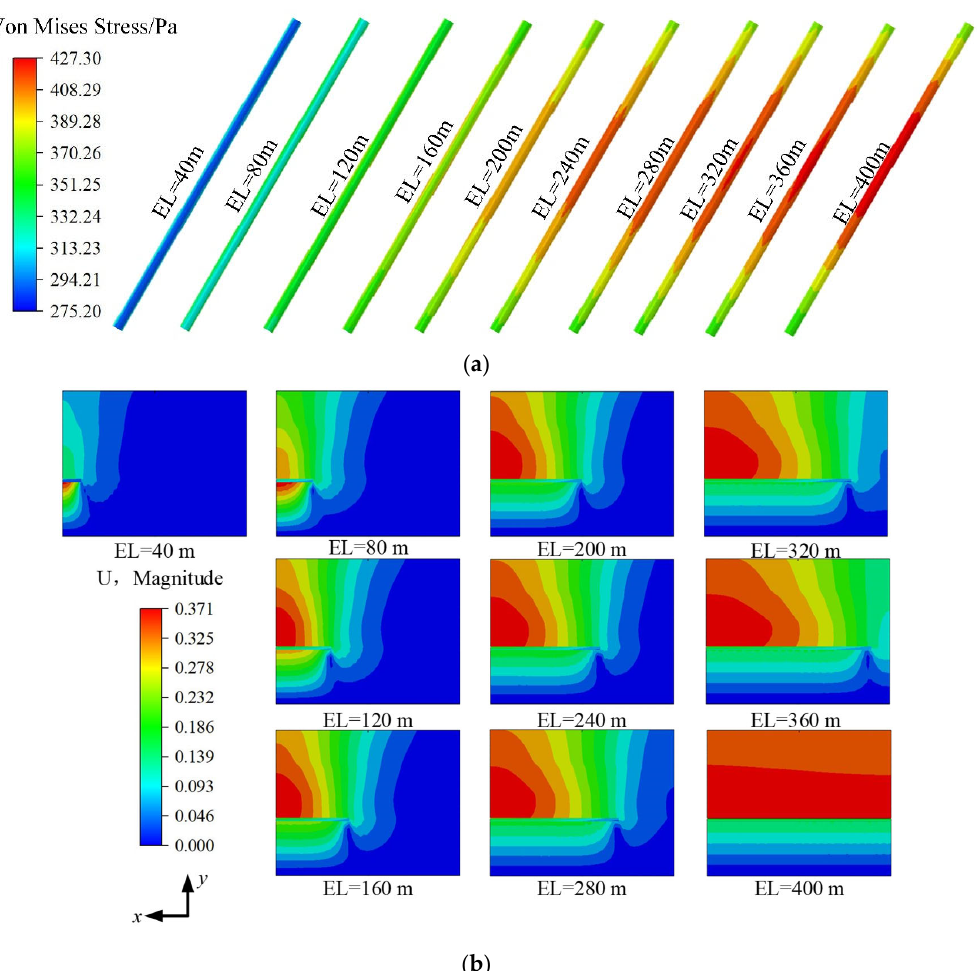
Figure 7. Pipeline and formation cloud maps for di ff erent mining lengths. ( a ) Cloud maps of the pipeline stress for di ff erent mining lengths. ( b ) Displacement cloud maps of the strata for di ff erent mining lengths. mining